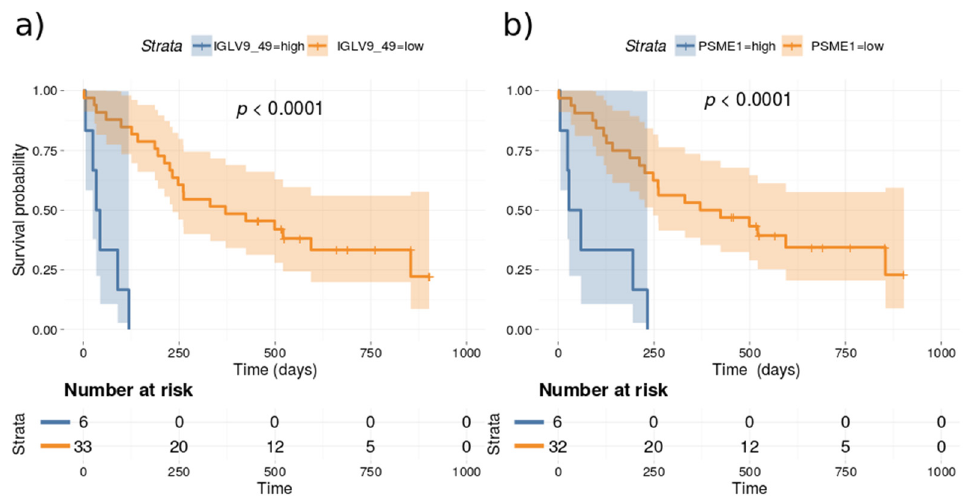
Figure 4. Kaplan–Meier based on dividing high and low expression of ( a ) IGLV9_49 and ( b ) PSME1.